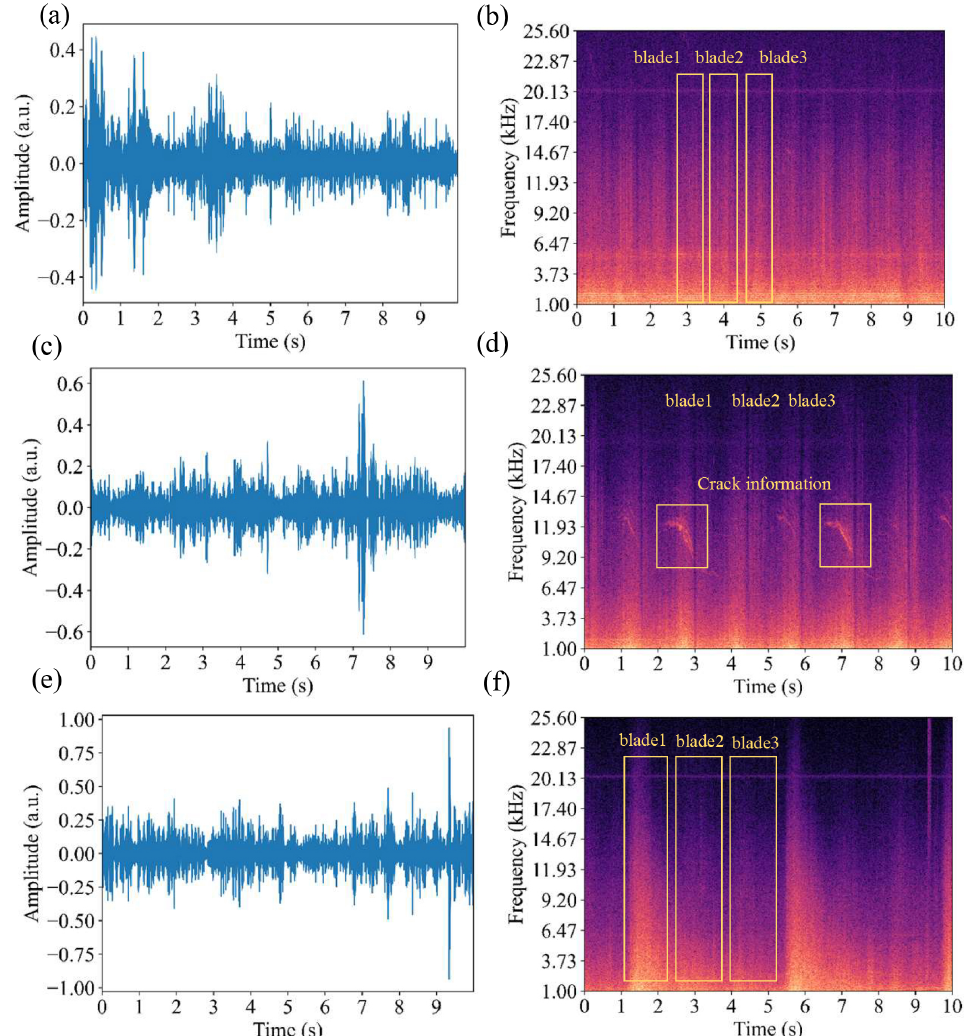
Figure 9. Time domain and spectrogram of different signals: ( a ) time domain and ( b ) spectrogram of normal signal; ( c ) time domain and ( d ) spectrogram of crack signal; ( e ) time domain; and ( f ) spectro- gram of unbalanced signal.